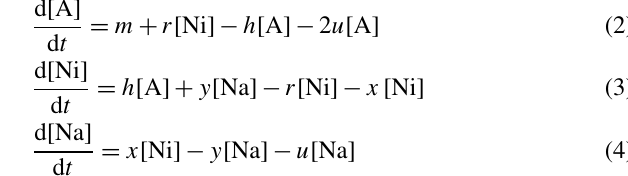
Estimated with ODE model